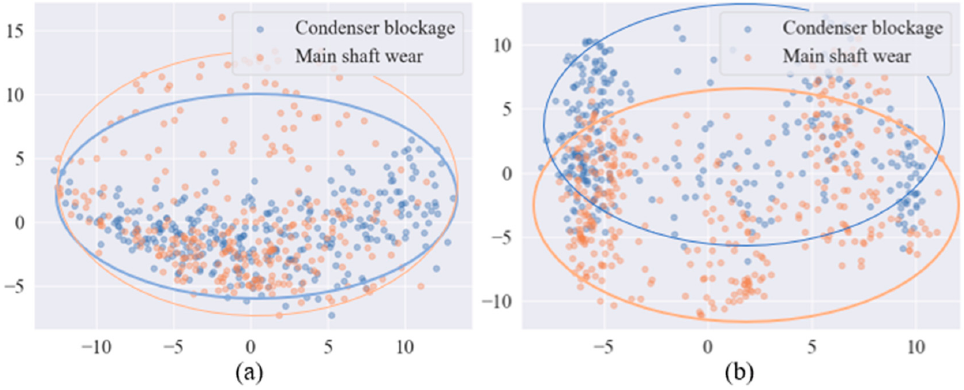
Figure 4. PCA results of DPCA sets and time domain sets. ( a ) Time domain set ( b ) DPCA set.